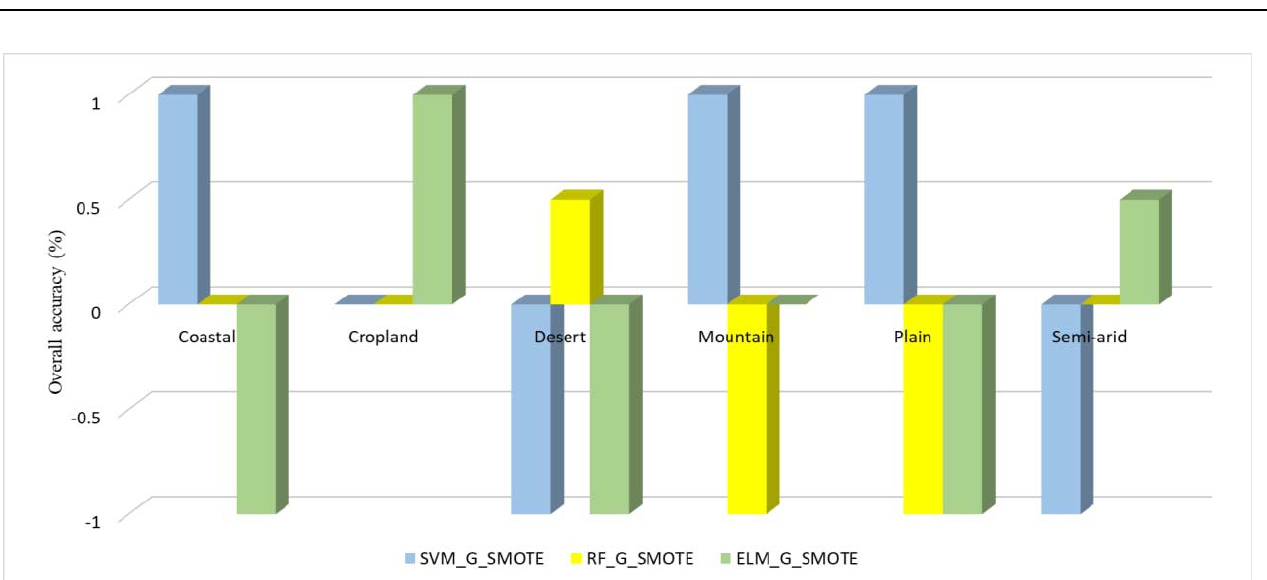
Figure 3. Impact of G-SMOTE on the overall accuracy of the generated LC maps.